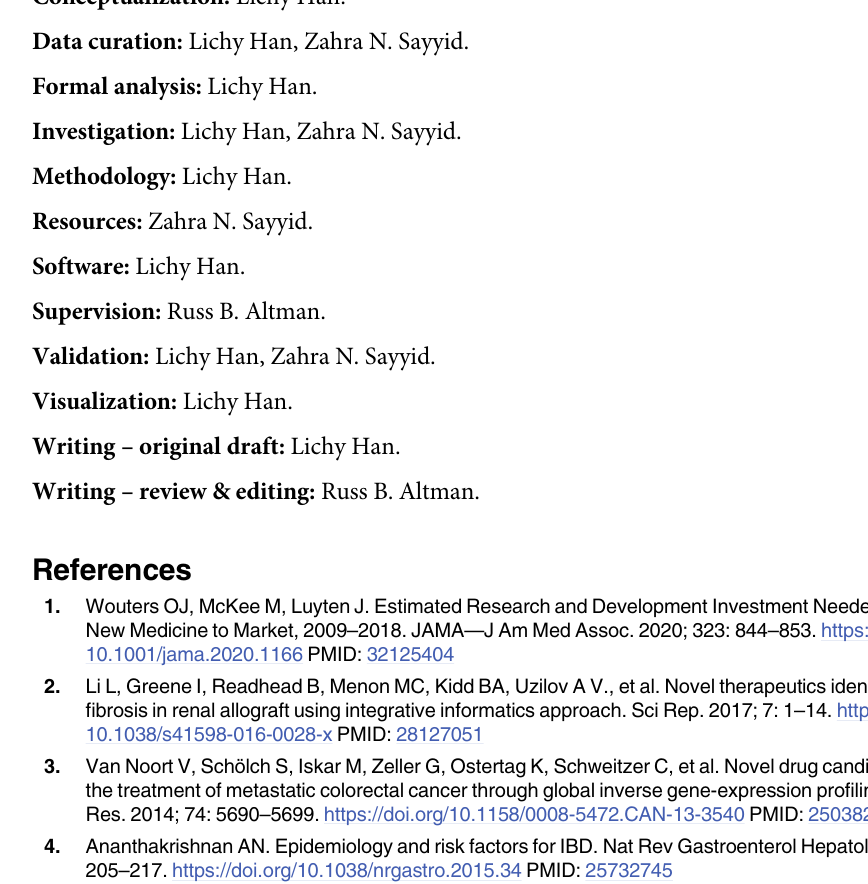
S1 Fig. Dendrogram of drugged profiles of a CD patient from GSE9686. Dendrogram branches are colored by the first level of the anatomic therapeutic chemical classification sys- tem. S1 Table. Dataset summary for publicly available mouse and human data.